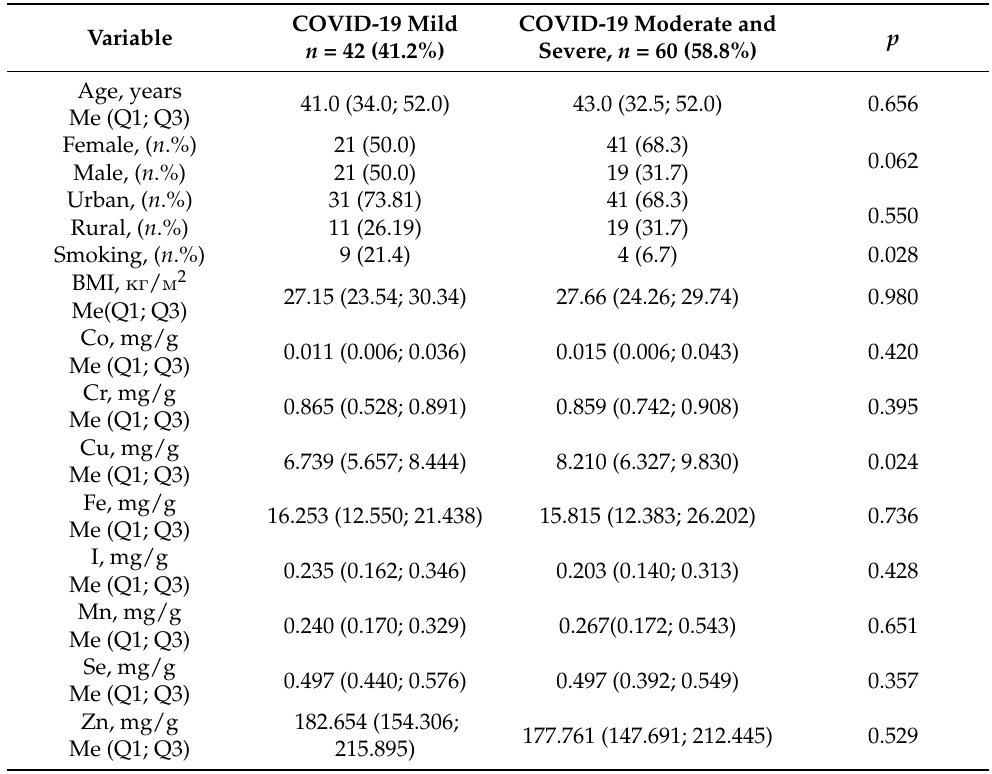
Table 2. Characteristics of study participants who had a coronavirus infection, depending on the severity of the disease.